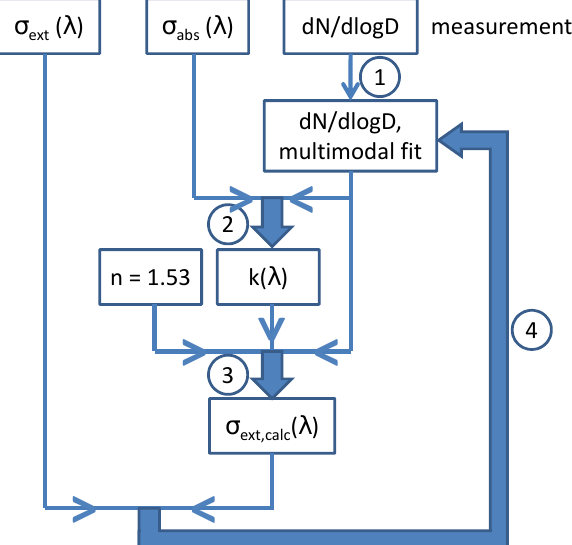
Fig. 7. Flowchart of the modified retrieval approach to deduce the wavelength dependent spectrum of the imaginary part of the com- plex refractive index, k(λ) , from the optical measurements. The concept involves the optimisation of the measured number size dis- tribution of the dust particles. The individual retrieval steps 1–4 are explained in the